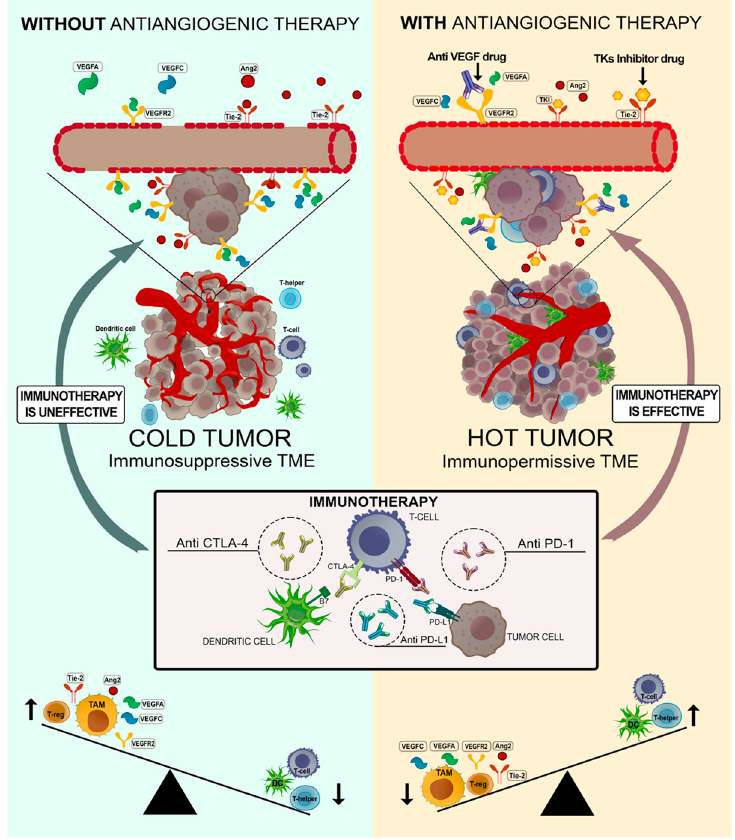
Figure 2. Schematic representation of the effects of antiangiogenic therapies on the conversion of an immunosuppressive (in blue) into an immunopermissive tumor microenvironment (in yellow). The immunosuppressive environment is characterized by fenestrated ( above ) and highly disorganized vessels ( middle ) and high levels of TAM, T-reg, Tie-2, Ang2, VEGFA, VEGFC, and VEGFR2 and low levels of T, T-helper, and dendritic cells ( bottom ), while the immunopermissive environment is characterized by the normalization of vessels and the inversion of expression levels of the same factors. This switch makes immunotherapy effective in highly vascularized BTCs. Abbreviations: TAM, tumor-associated macrophages; BTCs, biliary tract cancers; TME, tumor